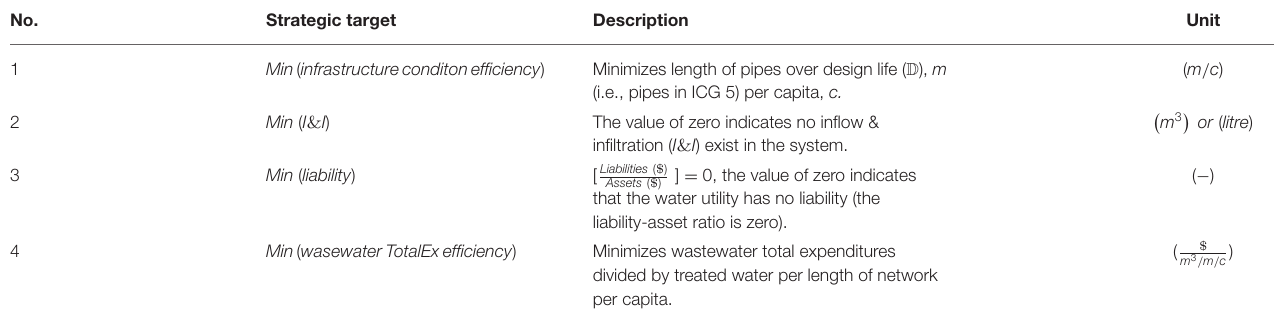
TABLE 2 | Strategic targets for asset management strategy of the wastewater collection network. No.